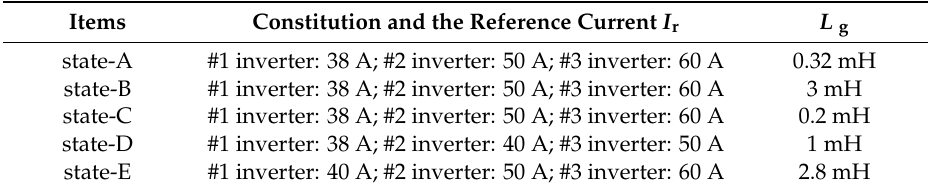
Table 4. Reference current and grid impedance for each state.